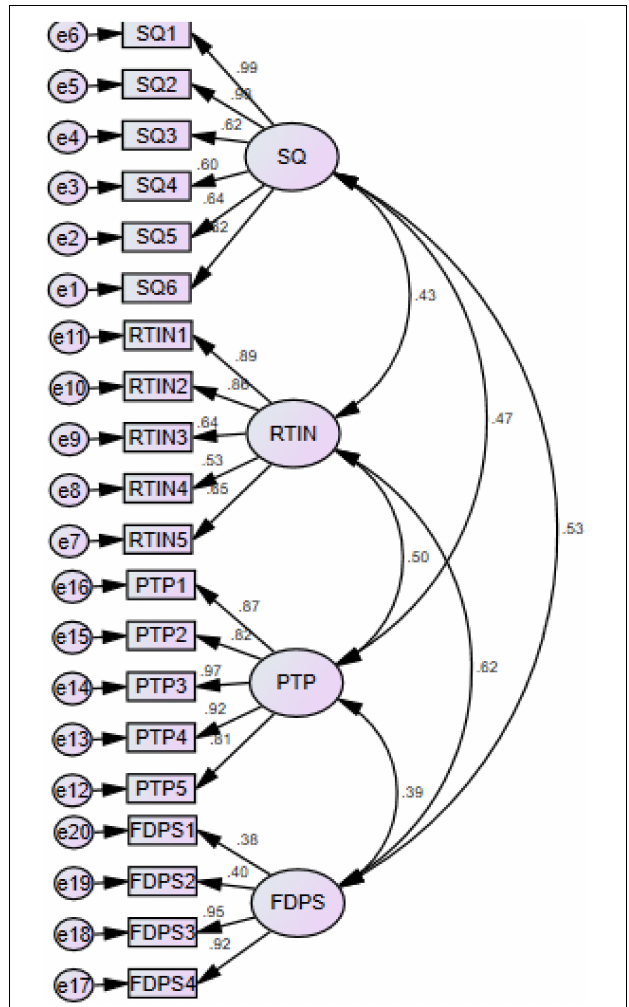
FIGURE 3 | Measurement model